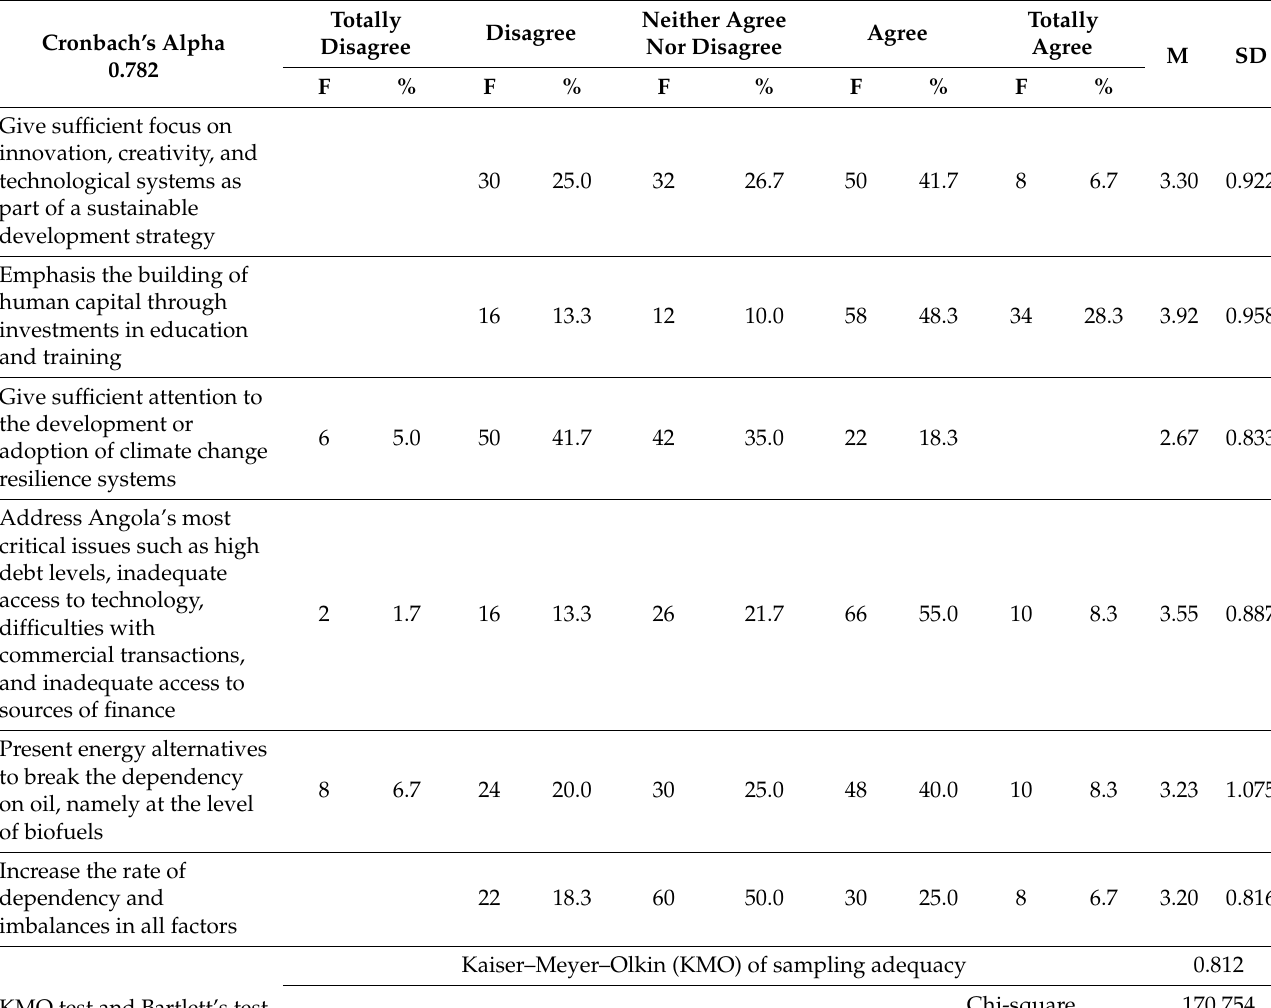
Table 7. Assessment of priority targets for Angola’s economic